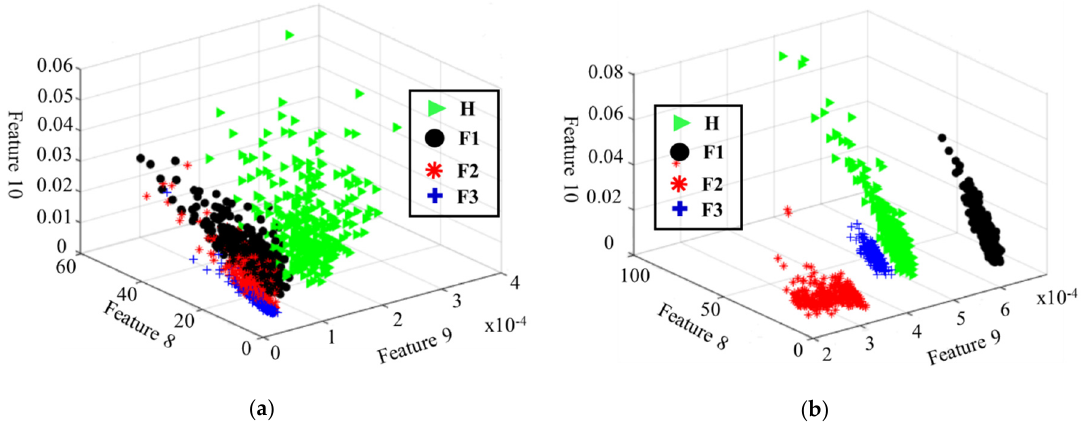
Figure 15. Three-dimensional visualization of features extracted from ( a ) the input signal of the ANR-GRS module and ( b ) the output signal of the ANR-GRS module.